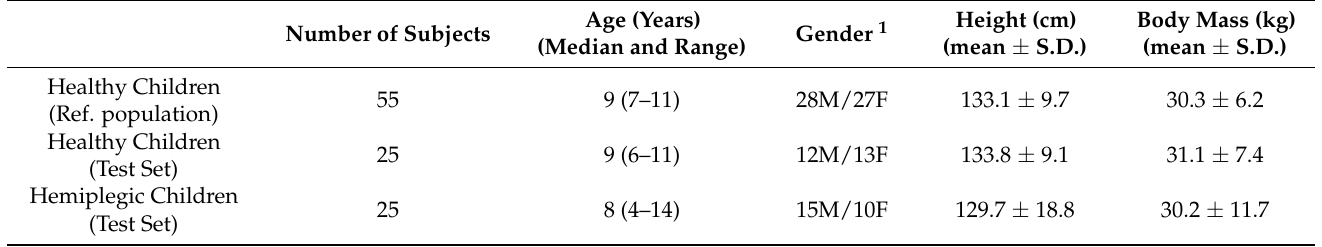
Table 1. Anthropometric parameters of the